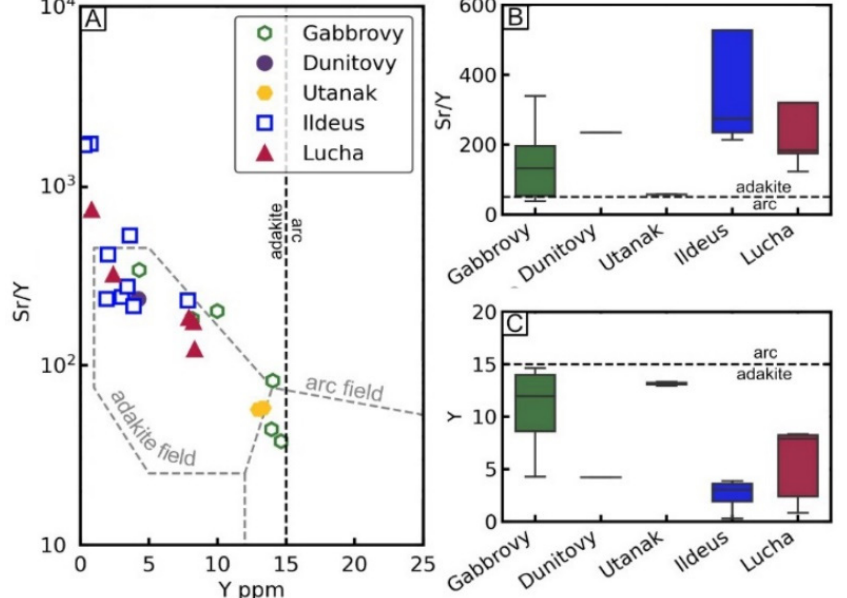
Figure 10. Sr/Y versus Y classification graph ( A ) and Sr/Y ( B ) and Y ( C ) variations in Stanovoy adakites. Compositional fields in ( A ) and boundaries in ( B ) and ( C ) are modified after [37,50]. The data in ( B , C ) are plotted showing the range and maximum/minimum of analytical values (excluding outliers), the 25th and 75th percentiles and the median (excluding outliers).